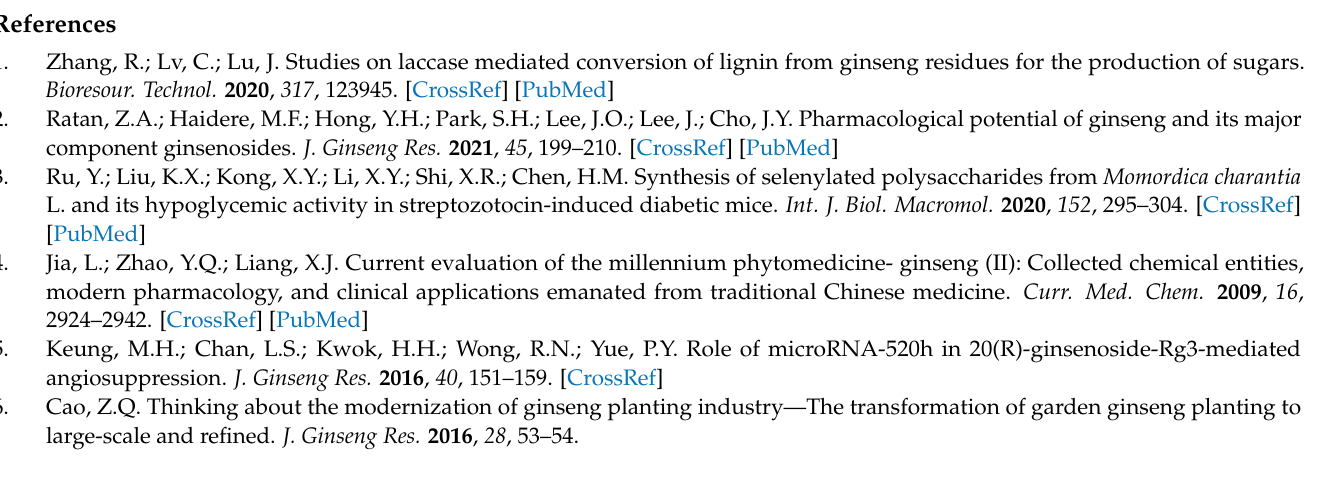
Table S1: The MRM for analysis of Butralin; Table S2: The parameters for the ESI source in HPLC- MS/MS; Table S3: Linear equation and matrix effect of butralin in different ginseng matrices; Table S4: Recovery and RSD ( n = 5) of butralin in ginseng; Table S5: The long-term dietary intake risk assess- ment of butralin based on the Chinese dietary